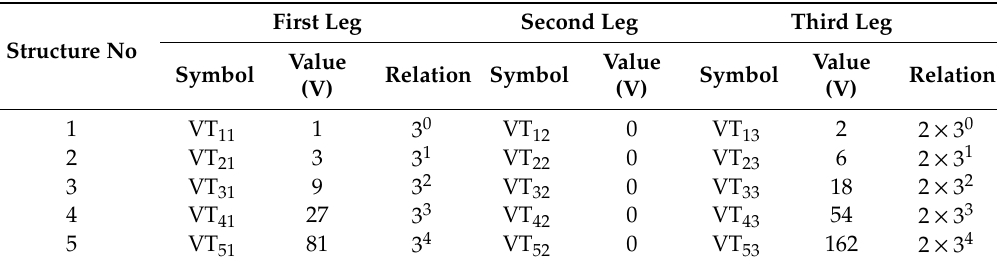
Table 7. Design procedure for the DC sources.